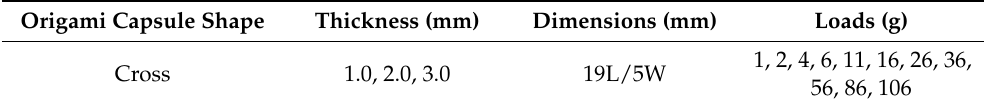
Table 2. Origami capsule